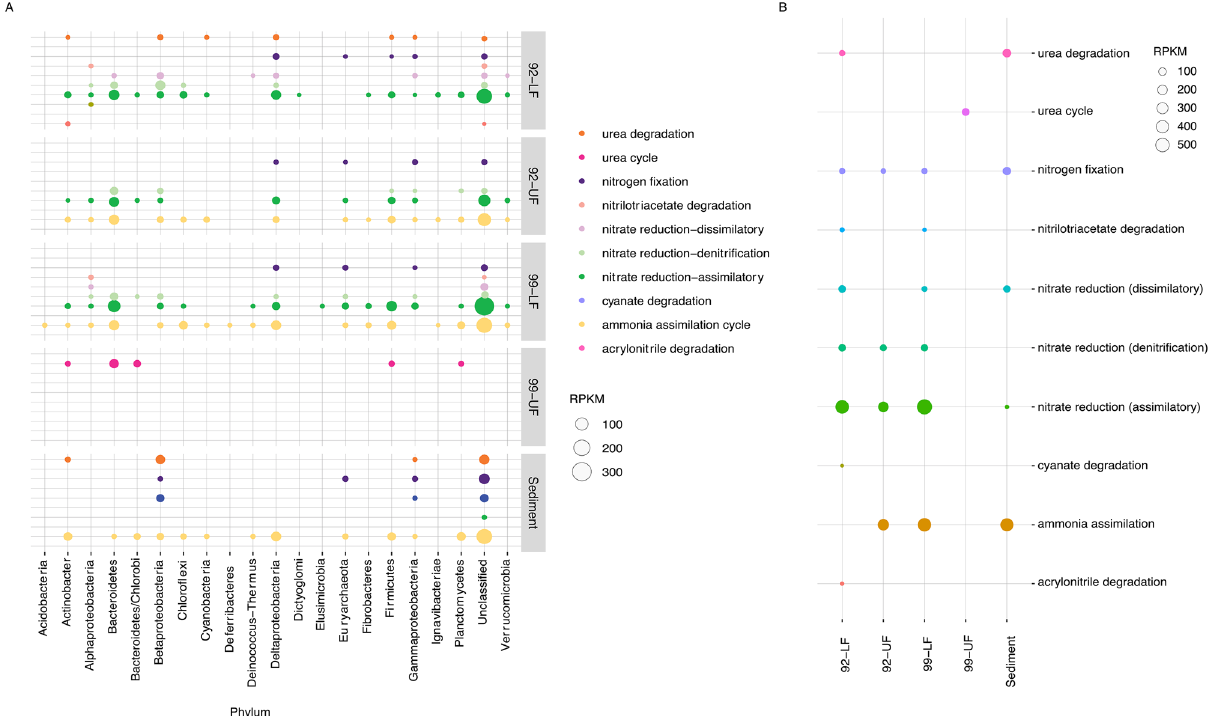
only 44% of the reads mapped back to the UF99 sample, not much information can be inferred from the data belonging to this sample. Nitrate reduction, the most abundant nitrogen metabolism reaction, can couple with methane oxidation and facilitate the usage of methane as an energy